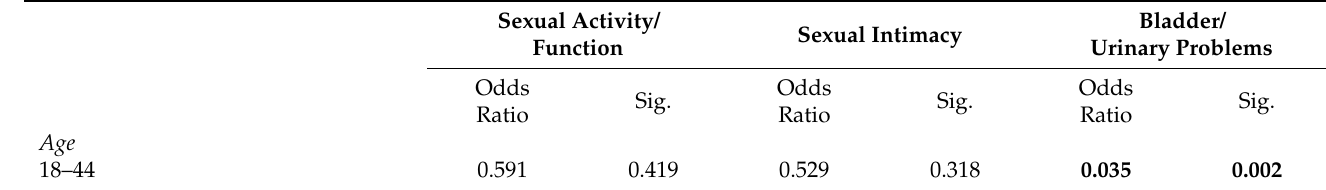
Table 9. Odds ratios from binary logistic regressions for genitourinary